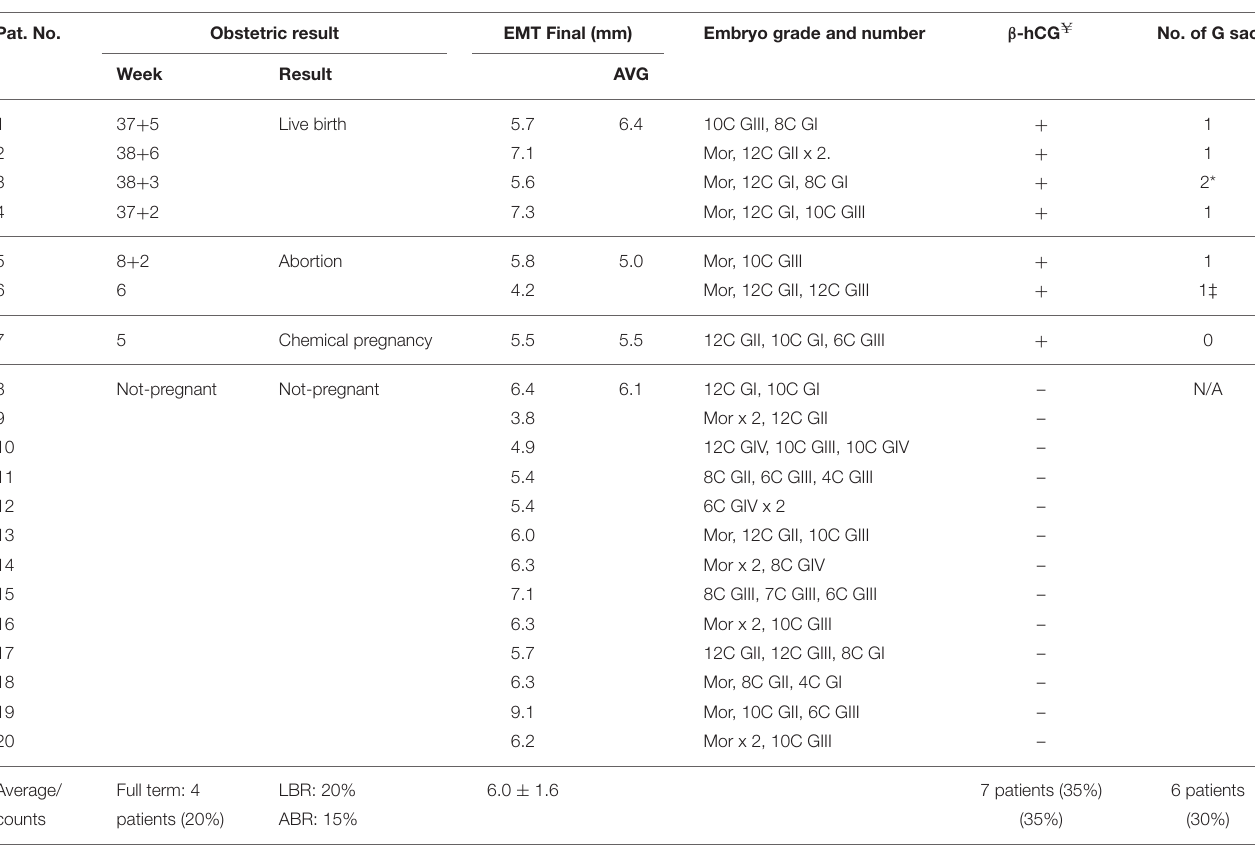
TABLE 2 | The results of autologous platelet-rich plasma treatment. Pat.